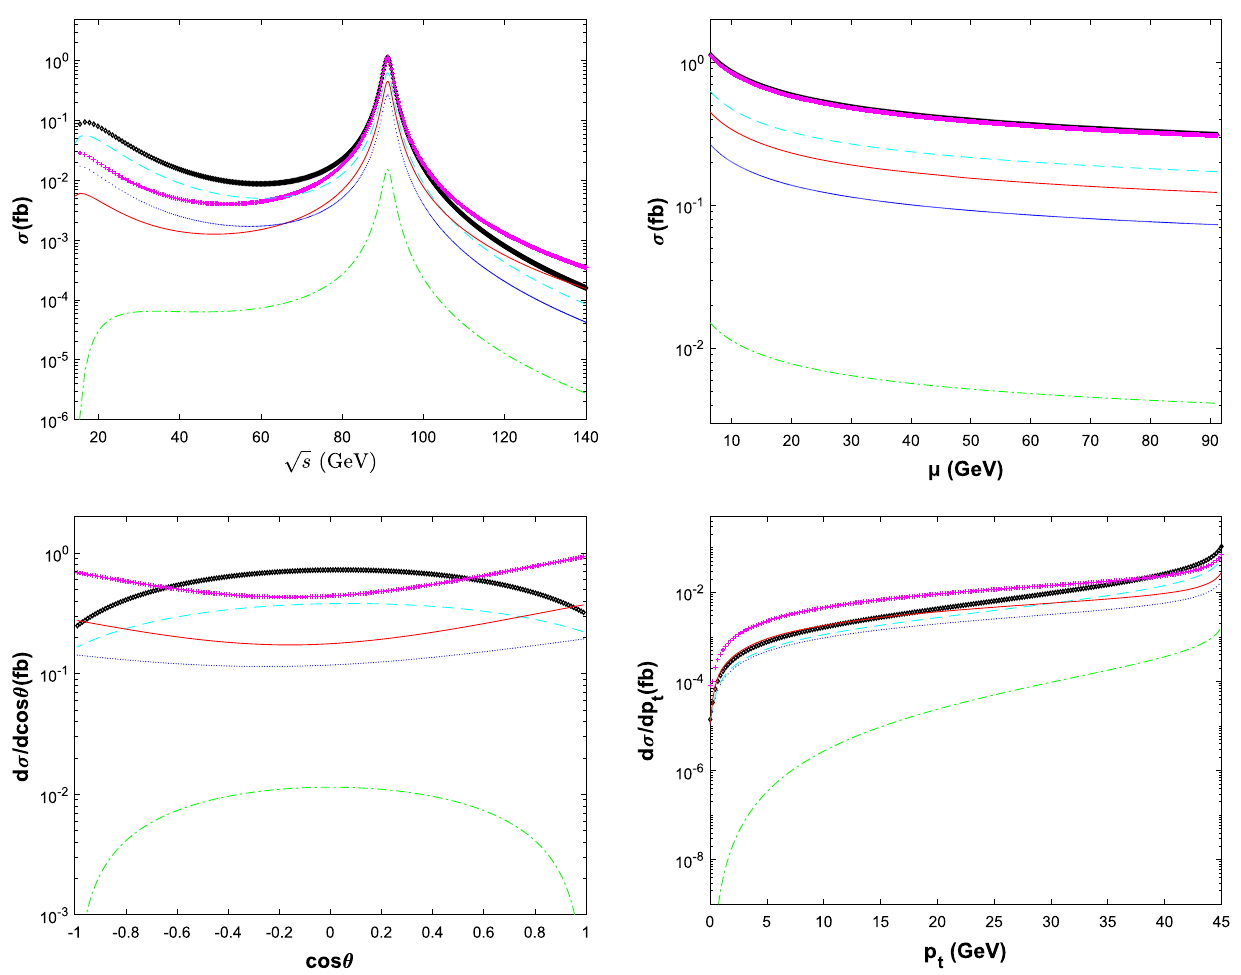
√ Fig. 4 Total cross sections versus the CM energy s and the renor- line, dotted blue line, and the dash-dotted green line are for the top six Z 0 propagated channelsinTable2: B malization scale μ , the differential angle distributions d σ /dcos θ , and √ s = m Z for the double B c production. the p t distributions d σ /d p t at The diamond black line, cross magenta line, dashed cyan line, solid red